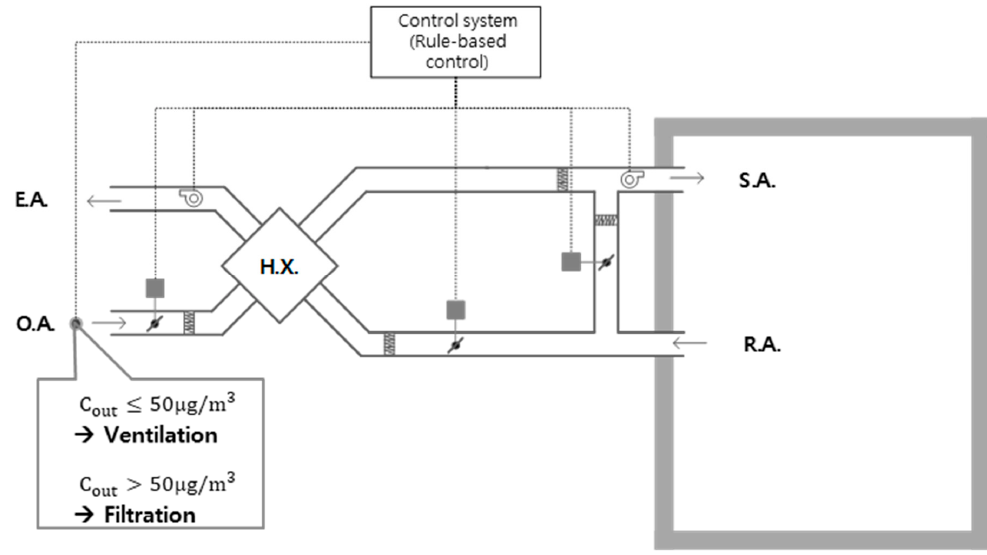
Figure 13. Schematic diagram of the ventilation and filtration system applied with the conventional control system. Table 5. Parameters associated with the space.